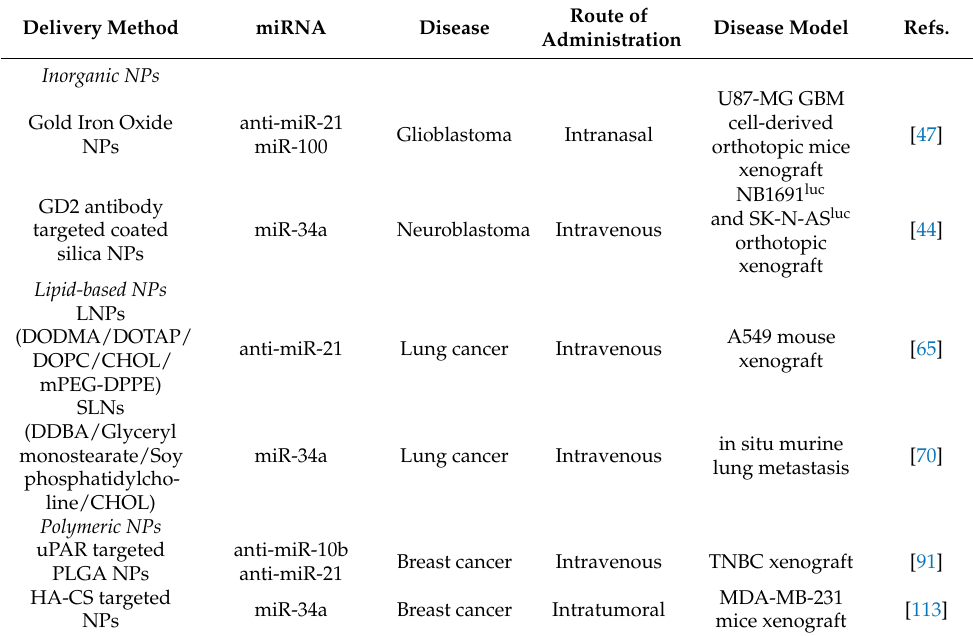
Table 4. Examples of delivery methods used for in vivo miRNA